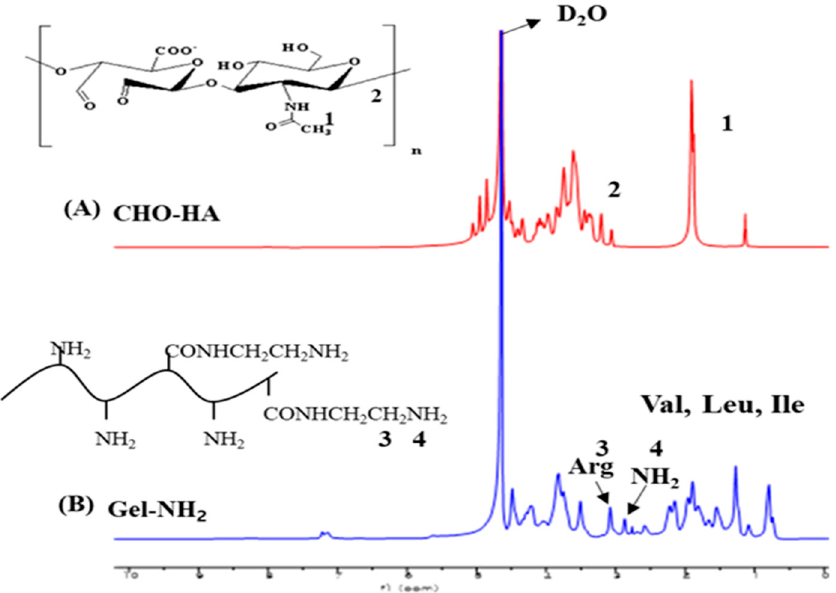
Figure 1. 1 H- nuclear magnetic resonance (NMR) results of modified hyaluronic acid (HA) and